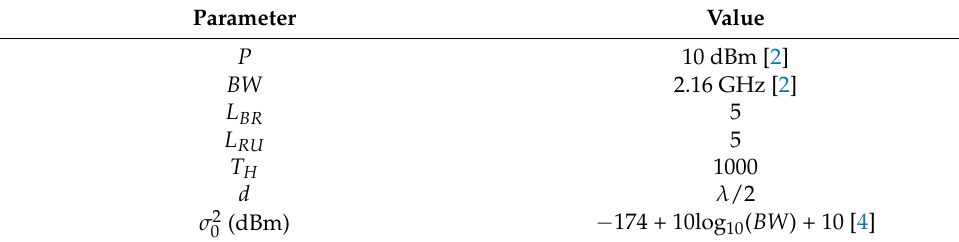
Table 1. Simulation